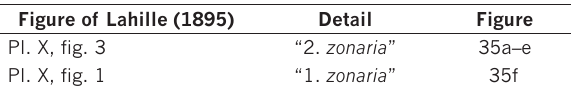
Pl. V, fig. 46 Pl. V, fig. 44 “5. Intermedia ” 34b